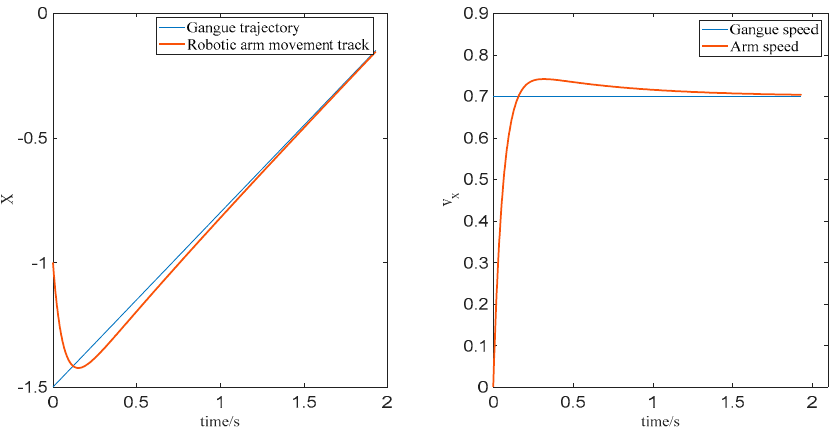
t ; takes the maximum values of the ig t , and Z − axis motion time iy